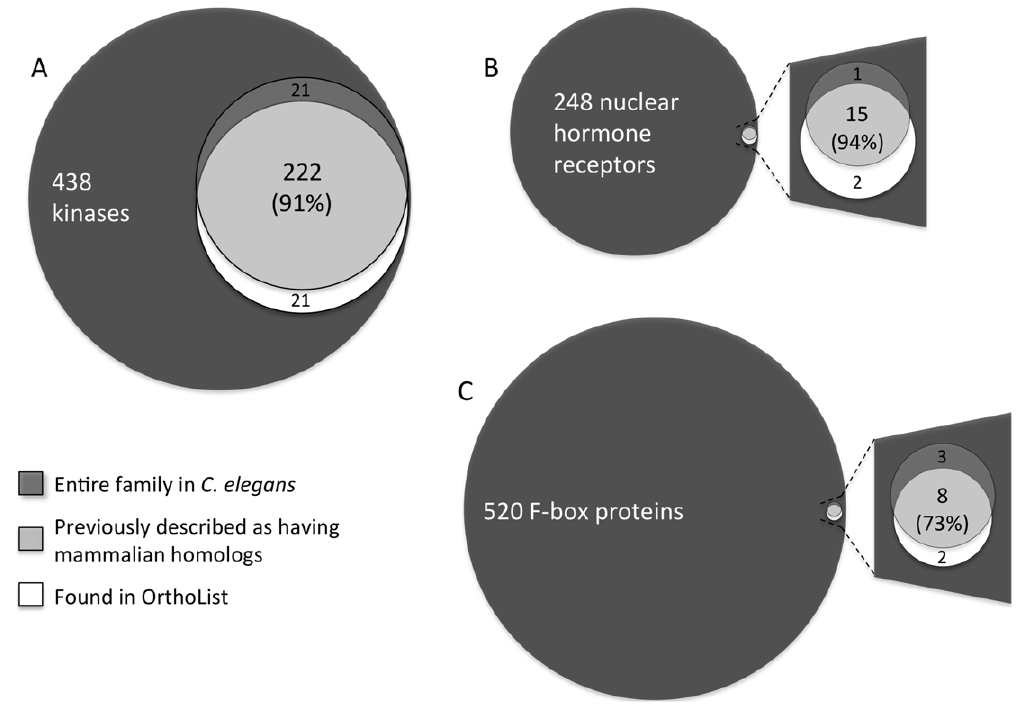
Figure 2. Examining OrthoList specificity and sensitivity. Venn diagrams comparing C. elegans gene families, and their previously defined conserved subsets, to members of the same families found in OrthoList (see Materials and Methods). For each family the overlap between OrthoList and the previously defined conserved subset is shown (the percentage refers to how well covered by OrthoList the conserved subset is). The possible homologs missing from OrthoList (putative false-negatives, shown above each overlap) and those found in OrthoList not previously defined as homologs (putative false-positives, shown below each overlap) are based on homology assignments of the original compendia for each of these families (see Materials and Methods, and [24–28,56]). As discussed in the main text, the number of false-negatives and false-positives may actually be lower. A) Kinases (see Table S3C for source data). B) NHRs (see Table S4A for source data). C) F-box proteins (see Table S4B for source data).